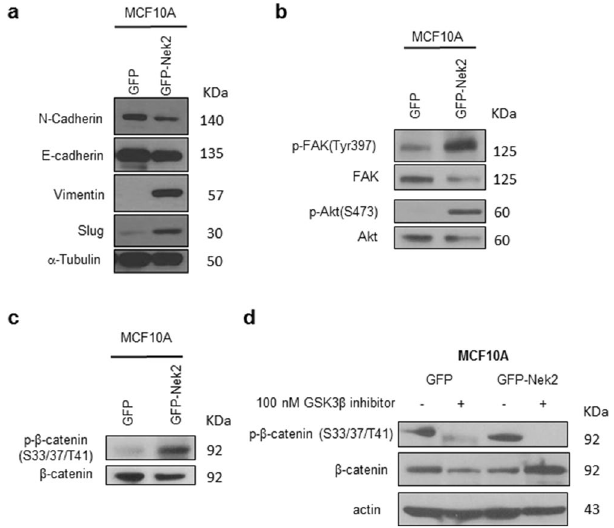
Figure 3. Nek2 regulates the epithelial-to-mesenchymal transition. ( a ) Immunoblotting of EMT pathway proteins. ( b ) Immunoblotting of phospho- and total Akt and FAK. ( c ) Immunoblotting of phospho- and total b-catenin in the presence or absence of inhibitor ( d